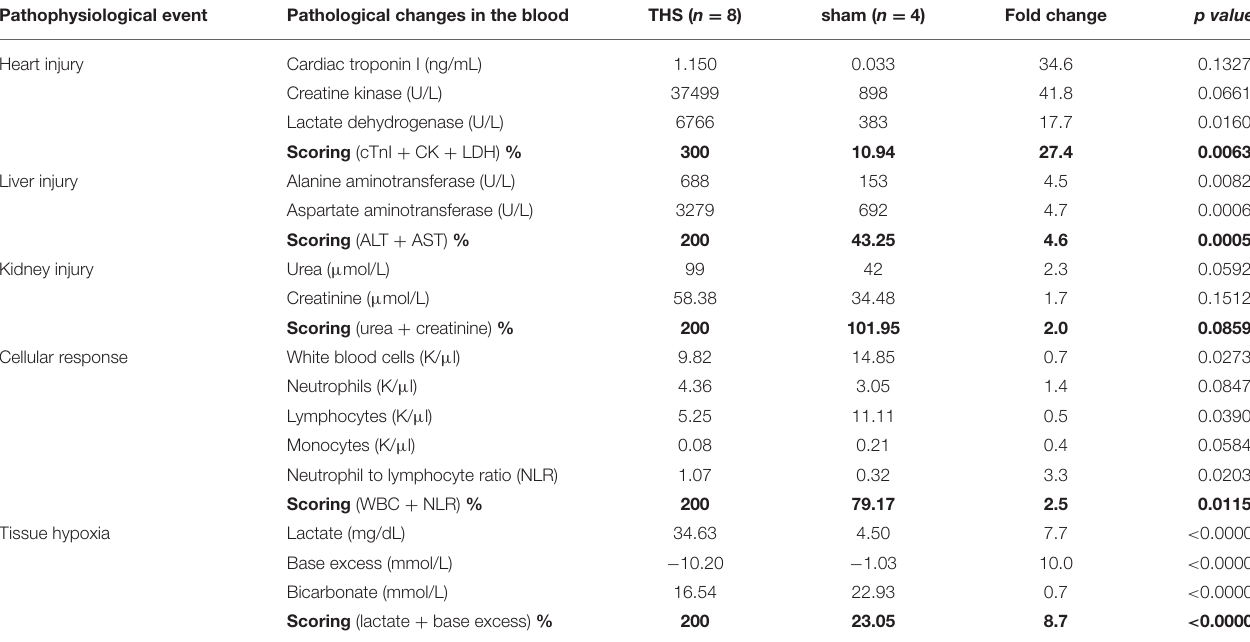
TABLE 1 | Pathological changes in the blood (PCB) analyzed in THS rat model. Pathophysiological